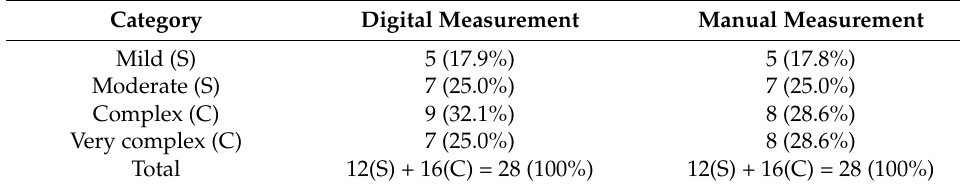
Table 5. Categorization of the discrepancy index according to